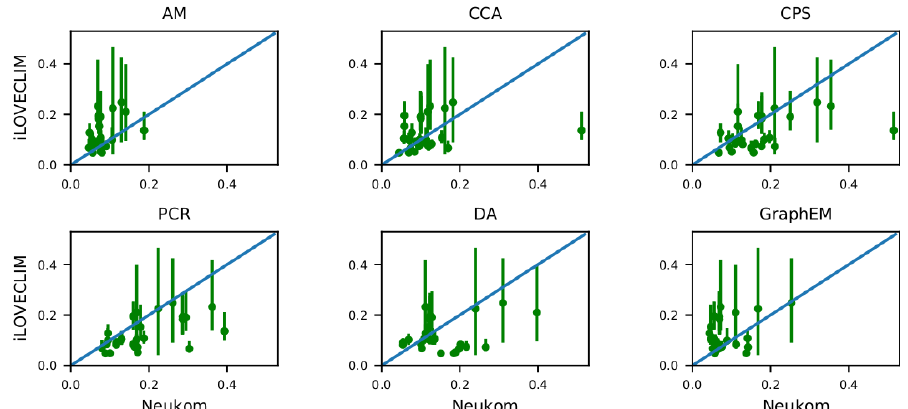
Figure A12. Local temperature variability in the PAGES-2k data set (Neukom et al., 2019) versus simulated i LOVECLIM SST variability at Ocean2K locations. For the PAGES-2k data set the six different CFR methods are shown in the individual panels. The vertical bars in the panels shows the range of simulated i LOVECLIM variability over all ensemble members.